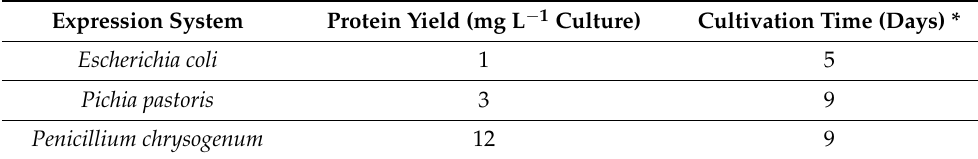
Table 2. Yield of purified Efe -AfpA from the different expression systems.